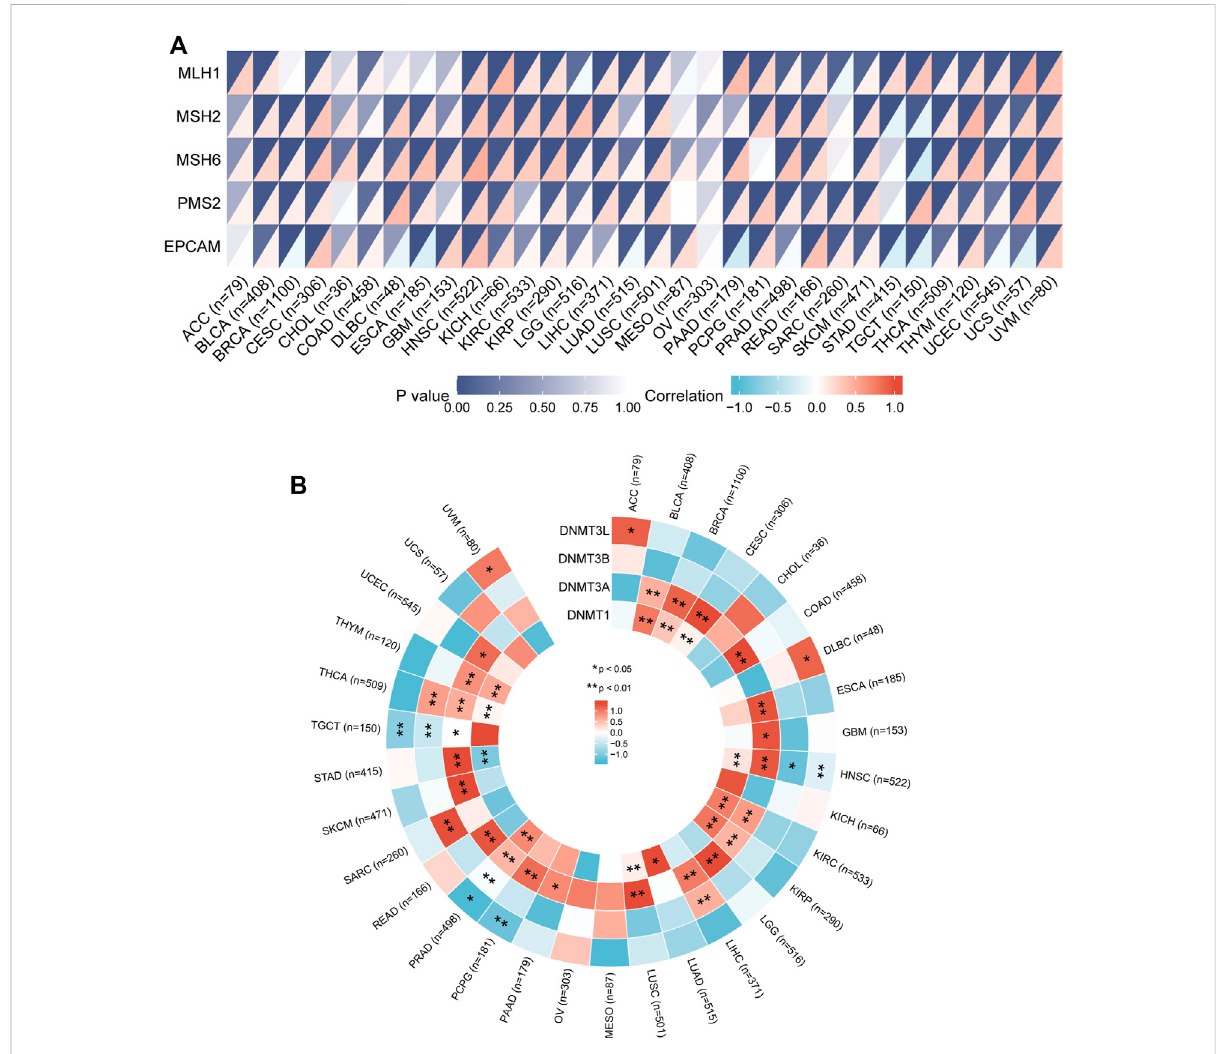
FIGURE 10 The associations of IGSF10 expression with MMR genes and DNA methyltransferases in pan-cancer. (A) Correlations between IGSF10 expression and fi veMMR genes ( MLH1 , MSH2 , MSH6 , PMS2 , EPCAM ) expression. The lower right triangle of each cell represents the correlation coef fi cient calculated by Spearman ’ scorrelation test,and the upperleft triangle represents the p -value. (B) Correlationsbetween IGSF10 expression and four DNA methyltransferase genes. * p < 0.05, ** p <